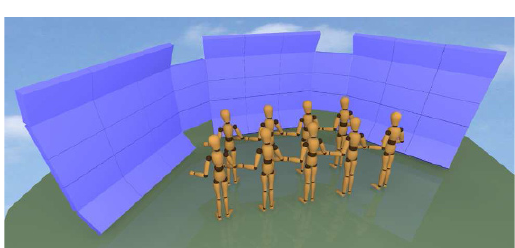
Figure 27. The proposed NG-CAVE will be built from tiling 51 near- seamless LCD panels, each fitted with micropolarization overlays providing a continuous circularly polarized 3D screen that can also be used to display 2D information. The NG-CAVE as currently conceived will provide 53 Megapixelsof stereoscopicresolutionand106 Megapix- els of monoscopic resolution. Illustration: Jason